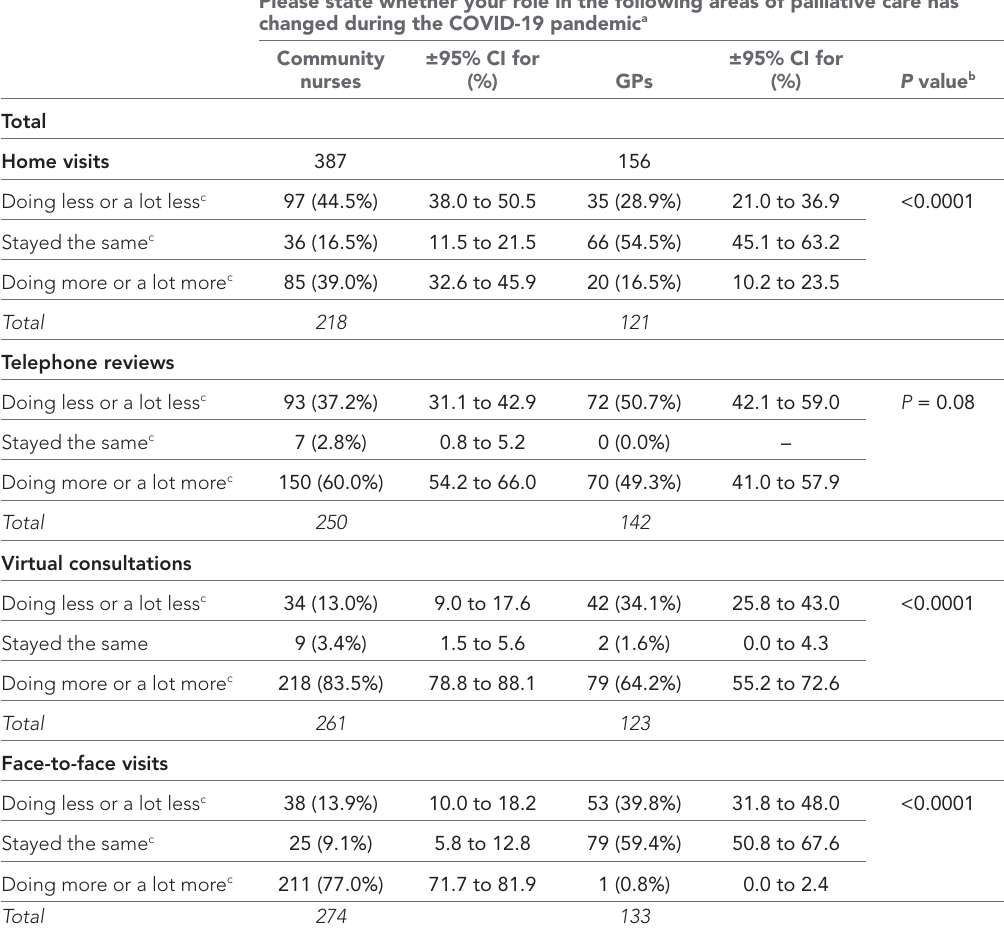
Table 3 Comparison between community nurses' and GPs' responses for the type of consultation